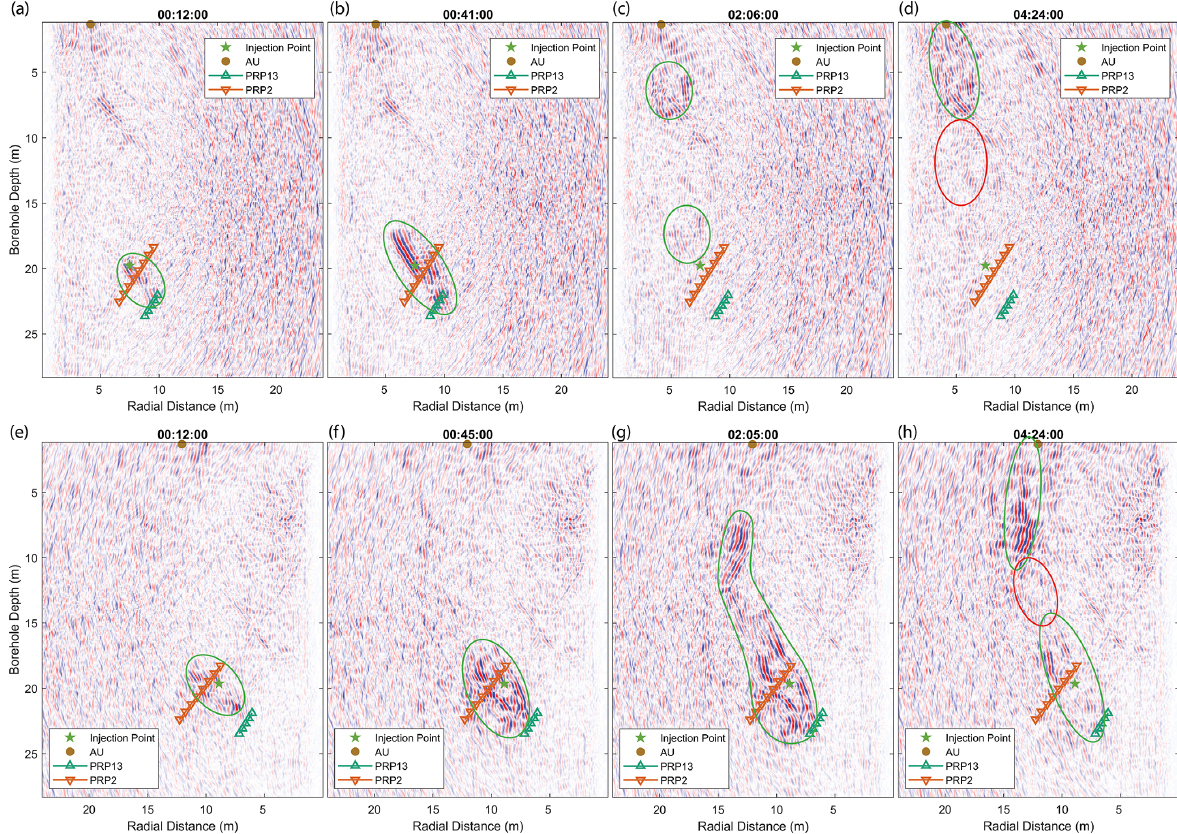
Figure 6. Time-lapse difference reflection imaging results. Panels (a) – (d) show the results for the experiment conducted in the GEO3 borehole at four different time steps. Panels (e) – (h) show the results at corresponding times for the experiment conducted in the GEO1 borehole. The identified tracer reflections are highlighted in green, while the regions with lower or lacking tracer reflection are marked in red. Note that the x axis with the distance from the borehole has an opposite direction for the two experiments, such that the geometry is better comparable. However, the reflections are not necessarily in the GEO1–GEO3 borehole plane due to the radial ambiguity.